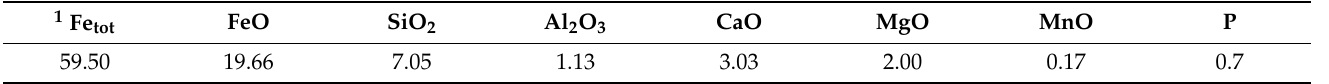
Table 1. Chemical composition of the raw magnetite iron ore,